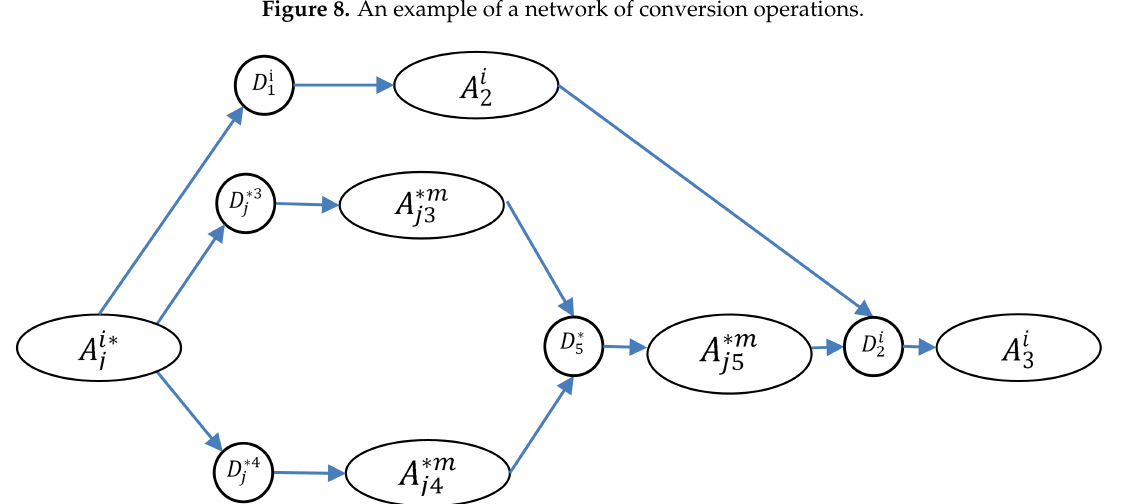
Figure 9. An example of a network of technological operations after